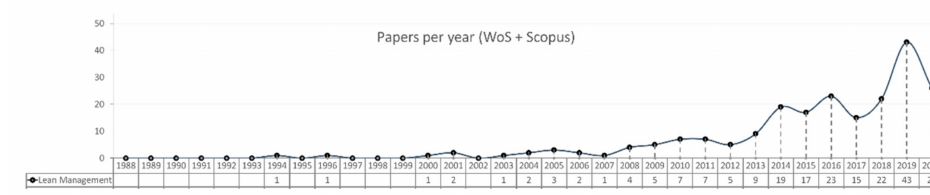
Figure 8. Lean management evolution.